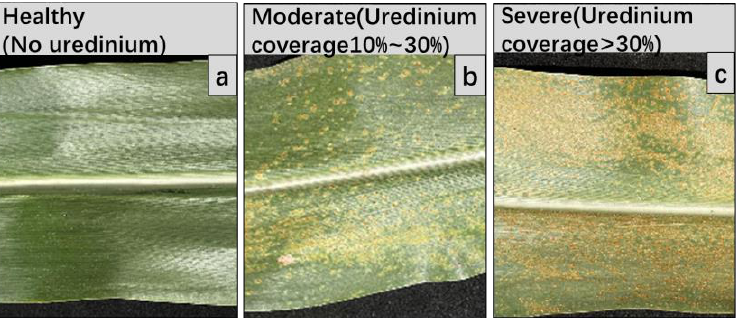
Figure 4. Corn leaves of healthy ( a ), moderately infected ( b ) and severely infected ( c ) leaves. Table 1. Sample numbers under different measuring